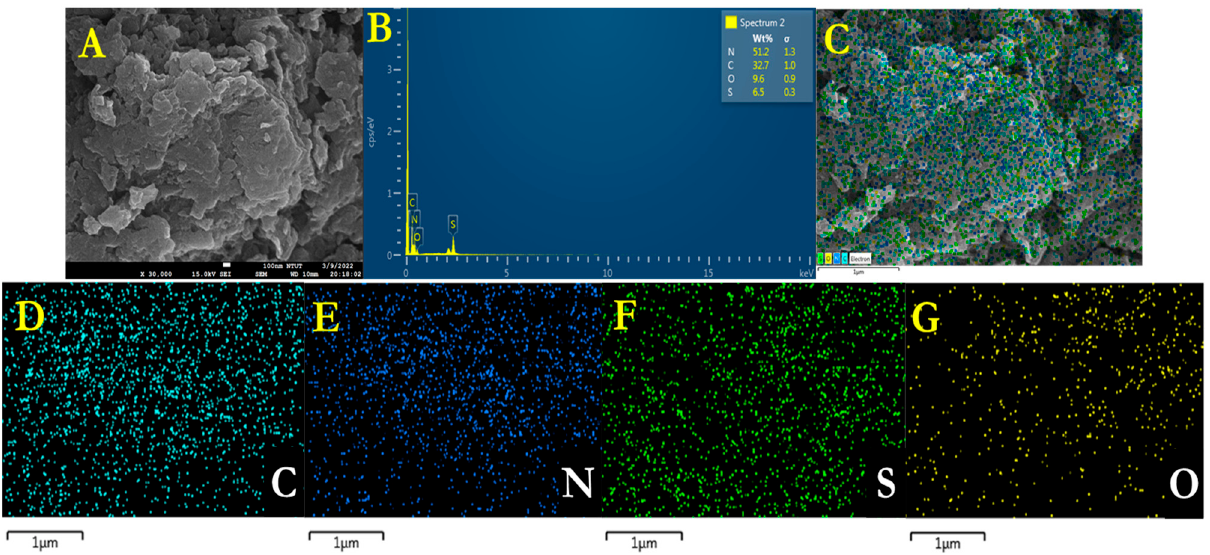
Figure 4. EDX spectra ( A , B ) and elemental mapping images ( C – G ) of the functionalized g-C 3 N 4 – SO 3 H photocatalyst.